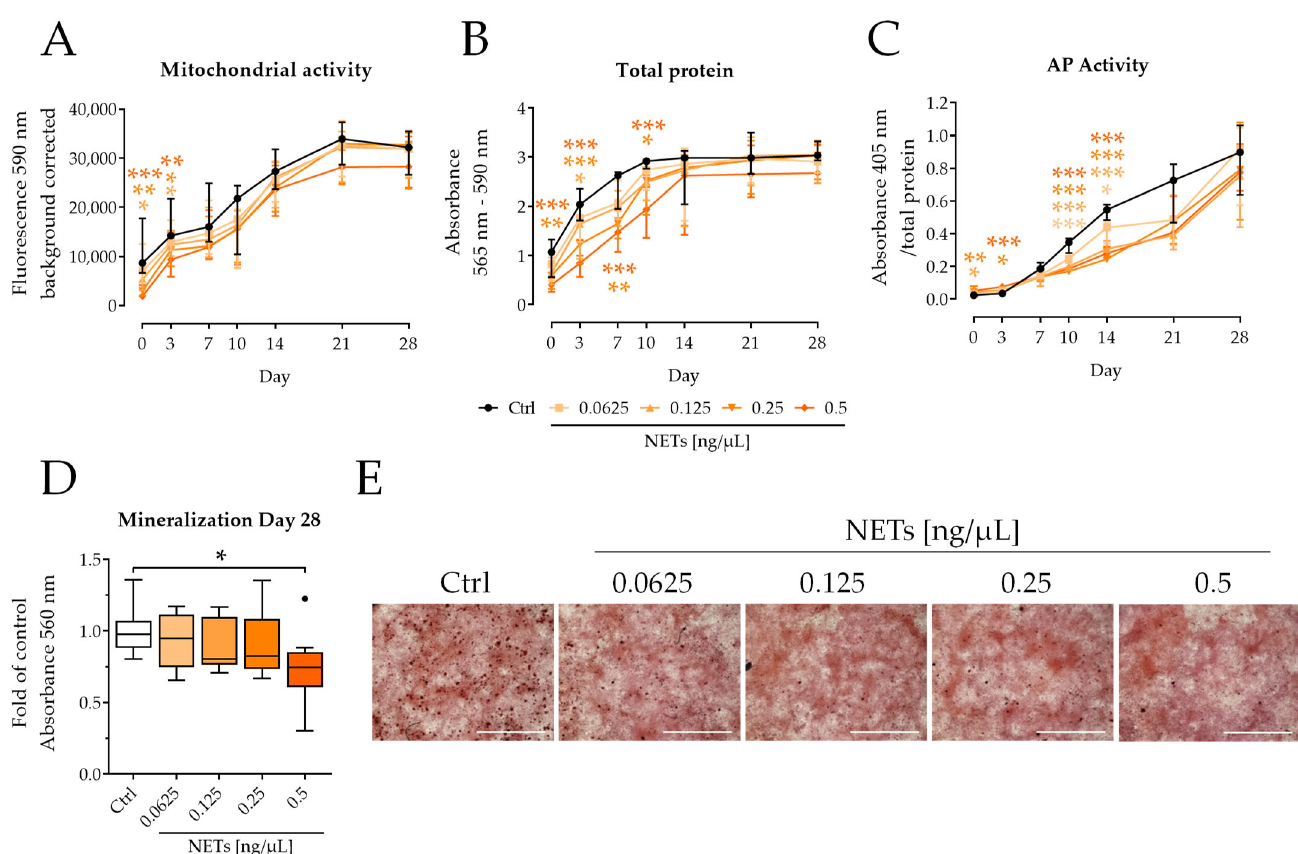
Figure 3. NETs impaired the differentiation of SCP-1 cells. SCP-1 cells were pre-incubated for 48 h with different concentrations of NETs, then osteogenically differentiated for 28 days. ( A ) Mitochon- drial activity was determined by Resazurin conversion. ( B ) Total protein content was determined by SRB staining. ( C ) AP activity was determined photometrically. ( D ) Matrix mineralization was determined by Alizarin Red staining on day 28 of differentiation. ( E ) Exemplary images of Alizarin Red staining on day 28. Original magnification 2×, scale bar 2000 µm. N = 4, n = 3. Median ± 95% CI. * p < 0.05, ** p < 0.01, *** p < 0.001, as determined by two-way ANOVA.